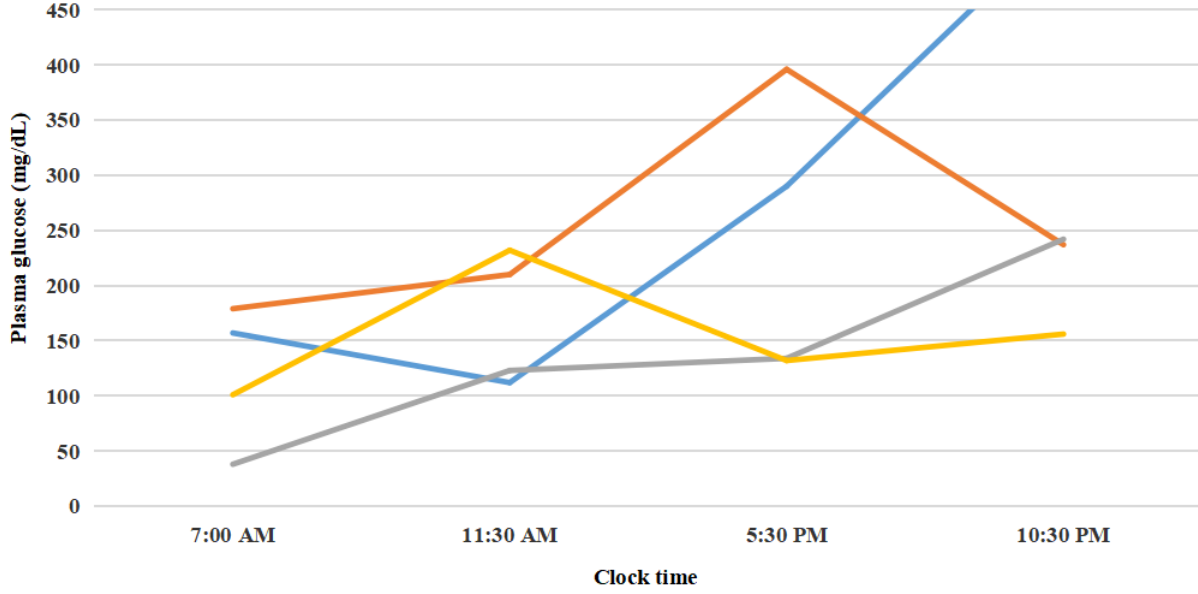
Figure 2. Glycemic variability in the patient with decompensated T1D